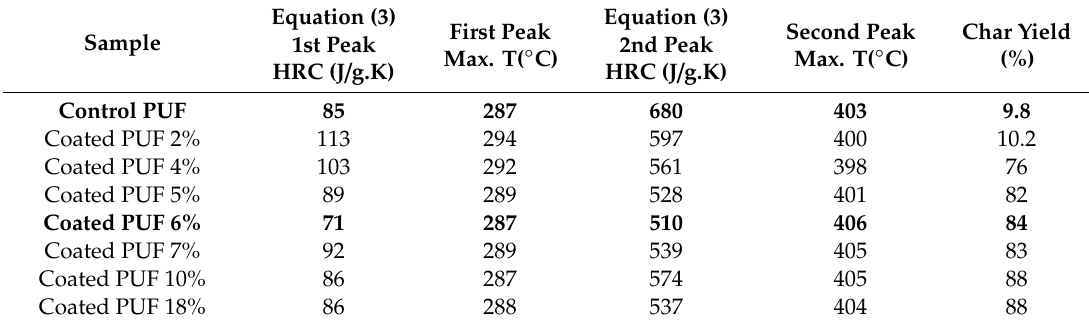
Figure 18. ( a ) MCC curve of coated PUF in di ff erent uptake, ( b ) Heat release capacity (HRC) of coated PUF in di ff erent uptake. Table 3. Heat release capacity and char yield percentage of the coated PUF for di ff erent